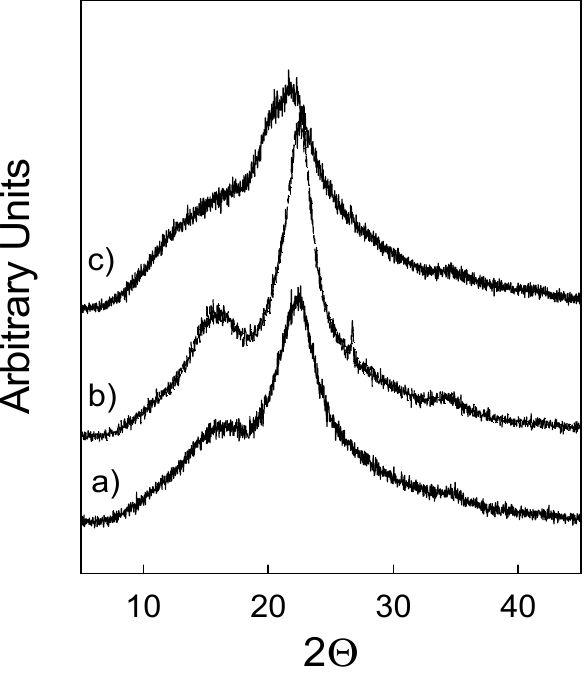
Figure 10. Powder XRD patterns of: ( a ) native eucalyptus residues, ( b ) pre-treated with [emim][HSO 4 ] and ( c ) pre-treated with [emim][OAc] IL.